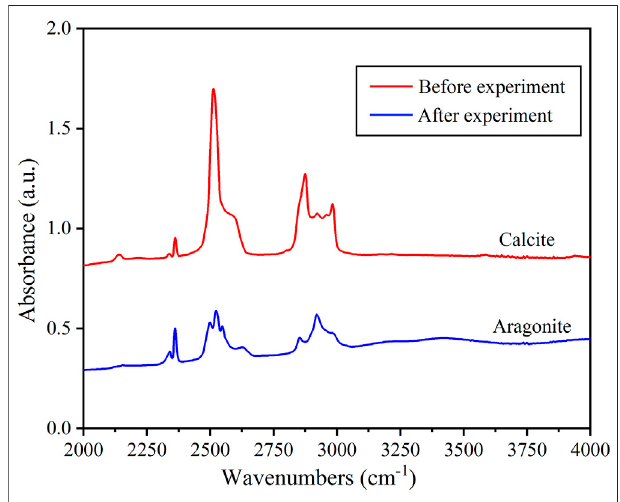
FIGURE 7 | Representative FTIR spectra for the three quenching samples before or after the